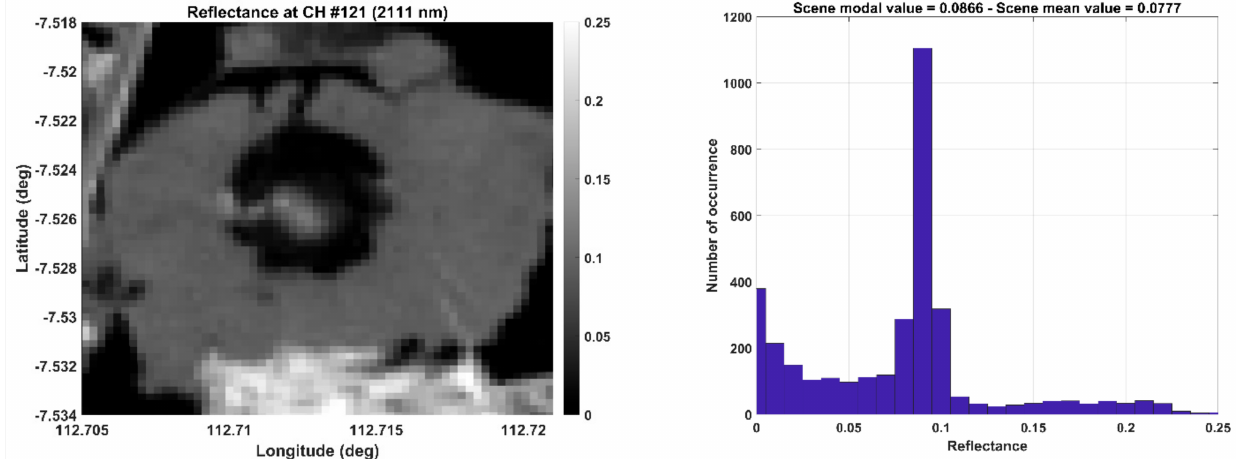
Figure 11. Reflectance from PRISMA L2D data product on LUSI.